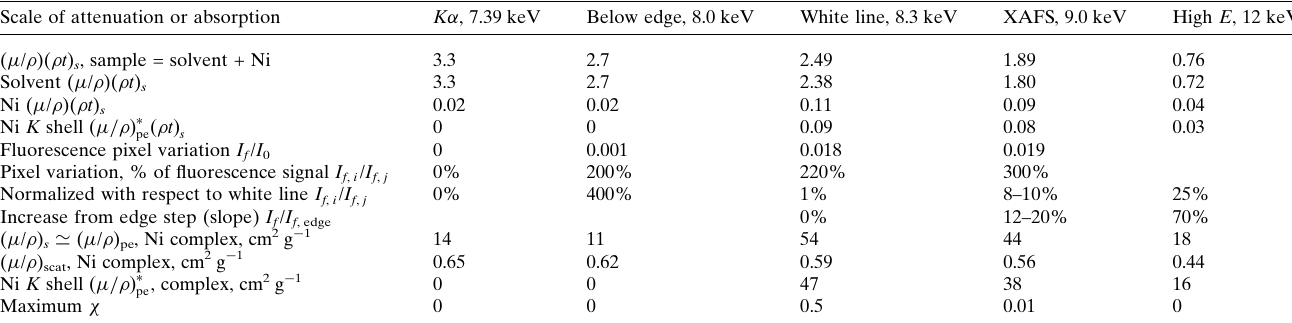
Table 2 Rough scales of attenuation in the 15 m M n -pr data set. Scale of attenuation or absorption